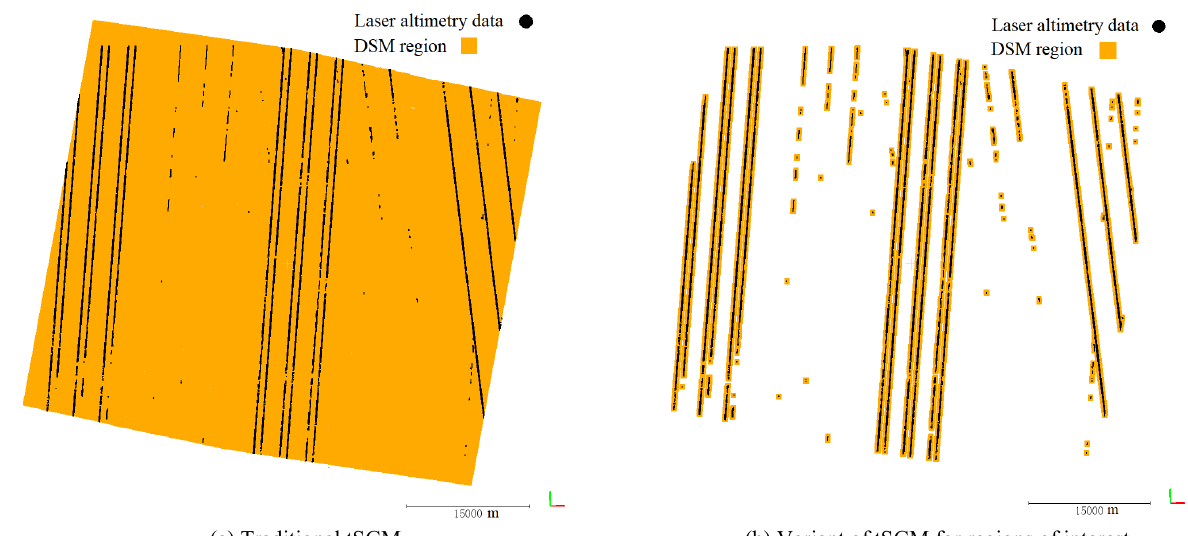
Figure 3. Distribution of DSM generated by different methods.